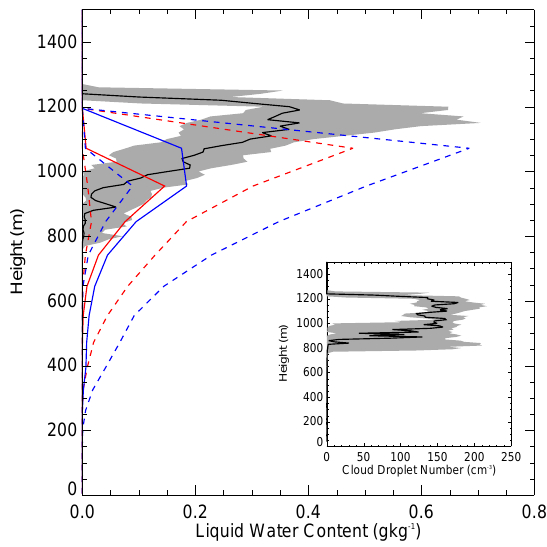
Fig. 5. Observed liquid water content median (black) and range (grey shading) from the profile ascent/descents of the BAe-146 near the Ron Brown around 15:00UTC on 12 November 2008. Over- plotted are the median and 5th/95th percentiles from a 1 ◦ region surrounding the Ron Brown from the 1 km control (red) and modified microphysics (blue) simulations. The inset panel shows the observed cloud droplet number concentrations from these flights.